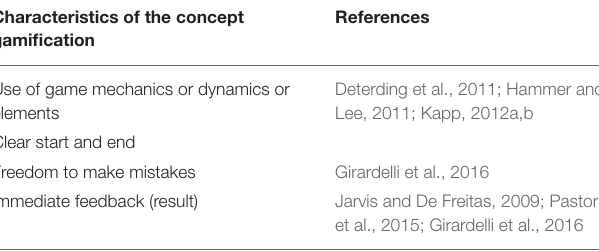
TABLE 3 | Characteristics of the gamification